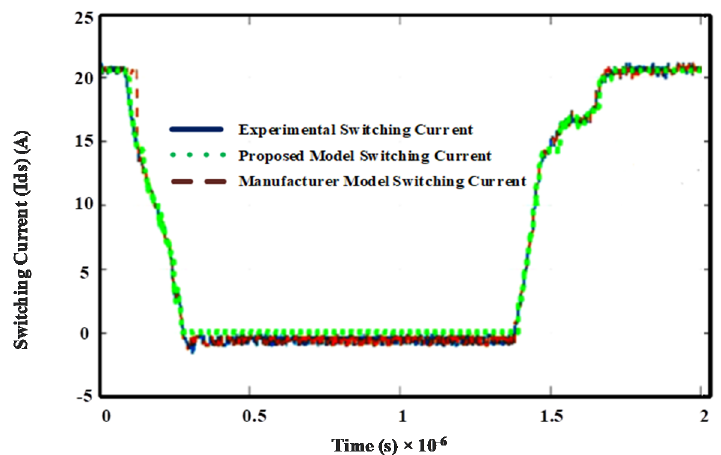
Figure 21. Comparison of gate voltage waveforms of models with DPT results. Electronics 2020 , 9 , x FOR PEER REVIEW